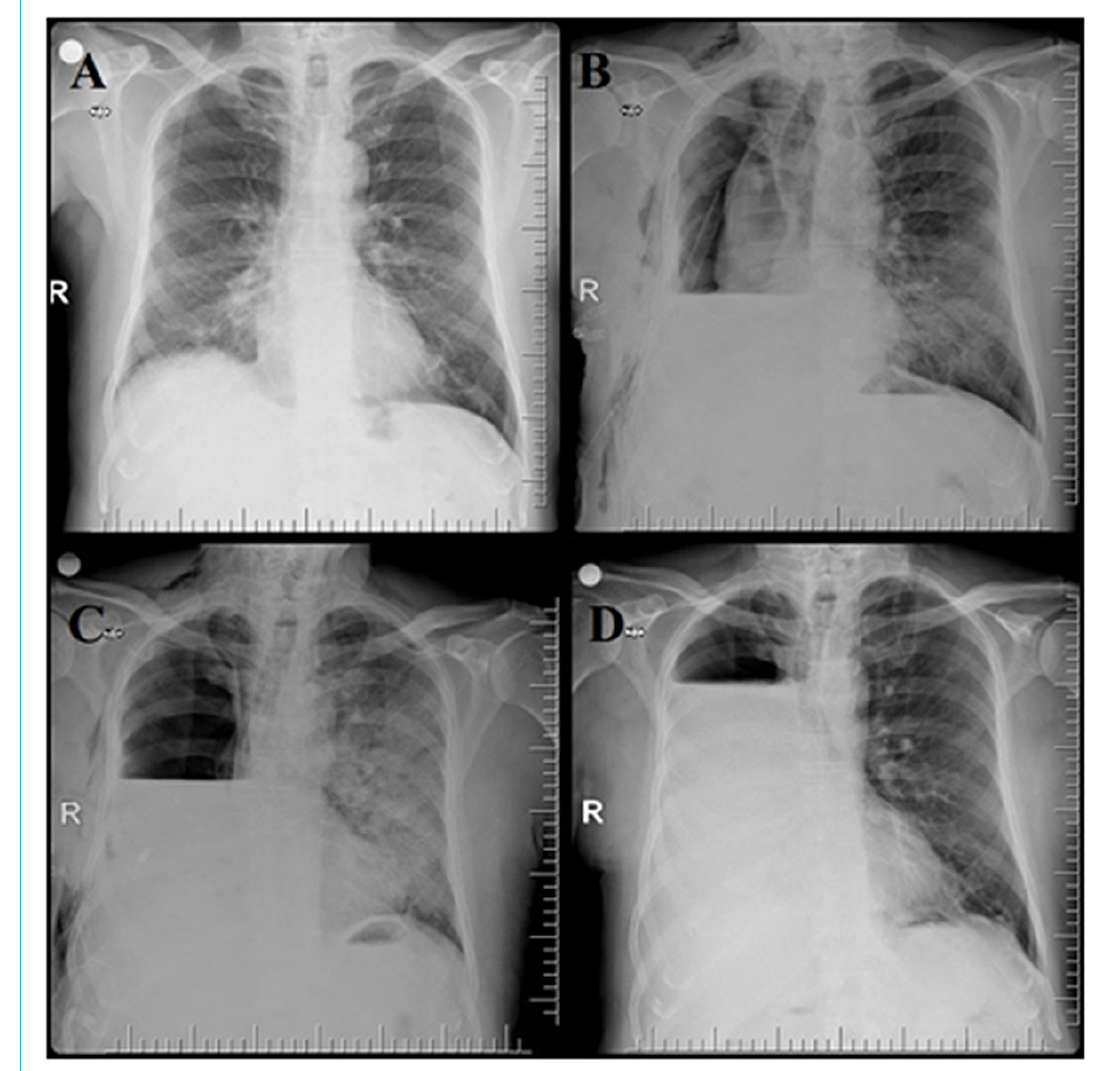
Figure 1: Chest x-ray findings in the perioperative period. (A) Normal chest x-ray in terms of pneumonia 7 days before surgery. (B) Postopera- tive day 1, non-homogeneous, non-specific minimal opacity in lower zones in the left lung. (C) Third postoperative day, non-homogeneous density increase in almost all of the left lung. (D) Sixteenth postoperative day, almost complete resolution was seen on the chest